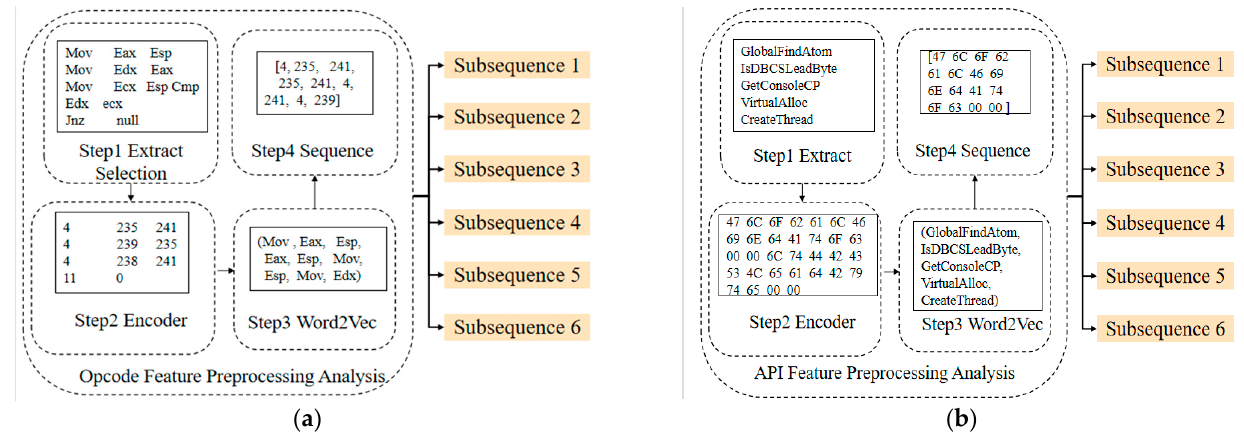
Figure 4. Feature pre-processing. They should be listed as: ( a ) Opcode feature preprocessing; ( b ) Api feature pre-processing.